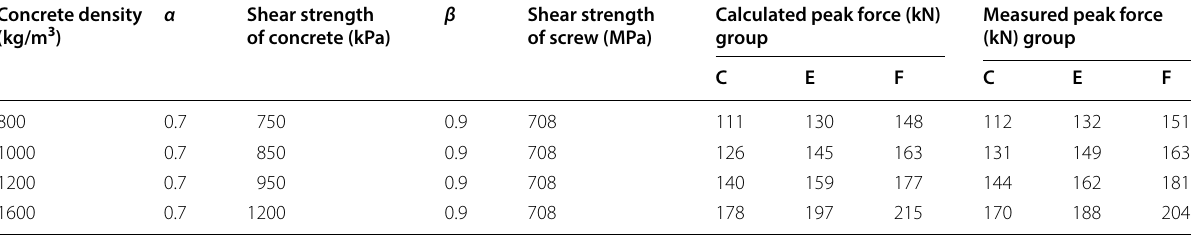
Table 4 Comparisons between calculated and measured peak vertical forces. Concrete density (kg/m 3 )